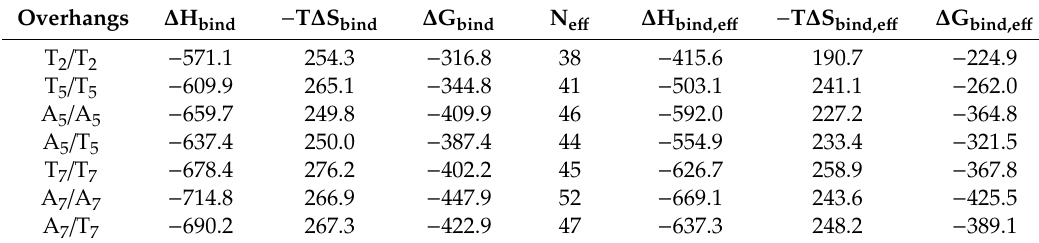
Table A1. Total and e ff ective enthalpy ( ∆ H bind , ∆ H bind,e ff ), entropy (-T ∆ S bind , -T ∆ S bind,e ff ), and free energy of binding ( ∆ G bind = ∆ H bind − T ∆ S bind , ∆ G bind,e ff = ∆ H bind,e ff − T ∆ S bind,e ff ) for ssiRNAs featuring complementary and non-complementary overhangs of di ff erent length with G 5 TEA-core PAMAM dendrimers. All values are in kcal / mol (standard deviation for all data in Table A1 is less that 3%). N e ff is the number of positive dendrimer charges e ff ectively involved in ssiRNA binding. Adapted from [57] with permission of the American Society of Chemistry.